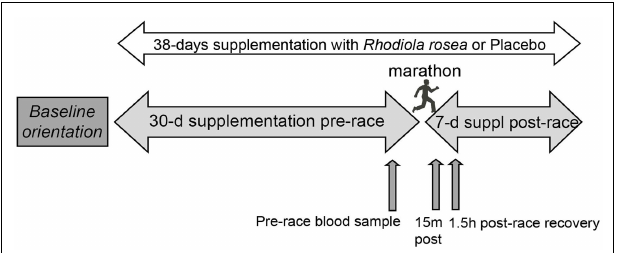
FIGURE 1 | Research design . Randomized runners ingested Rhodiola rosea ( N = 24) or placebo ( N = 24) for 30days prior to the marathon, the day of the marathon, and for 7days after the marathon. Blood samples were collected the day before the marathon (pre-race), approximately 15min post-marathon, and 1.5h post-marathon. Serum collected from the blood was stored at − 80°C until